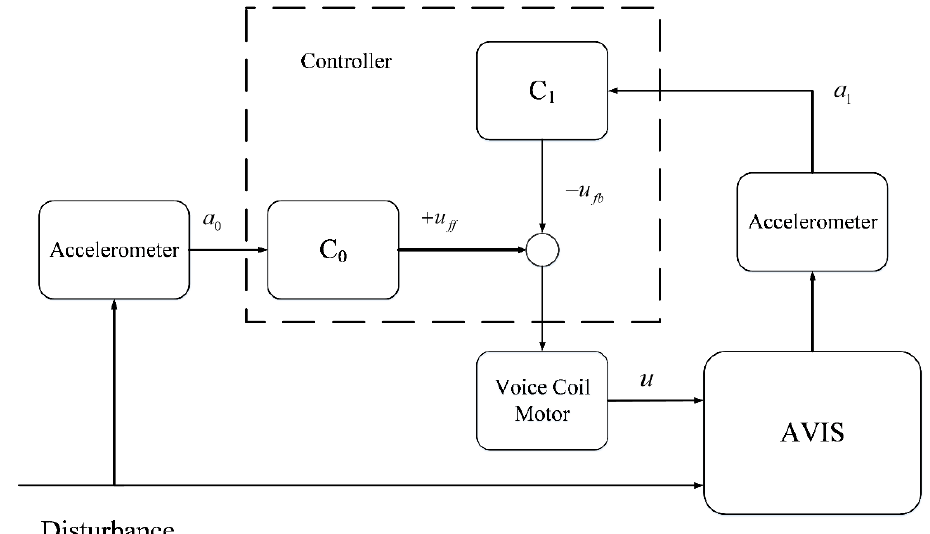
Figure 3. Control block diagram of the AVIS.